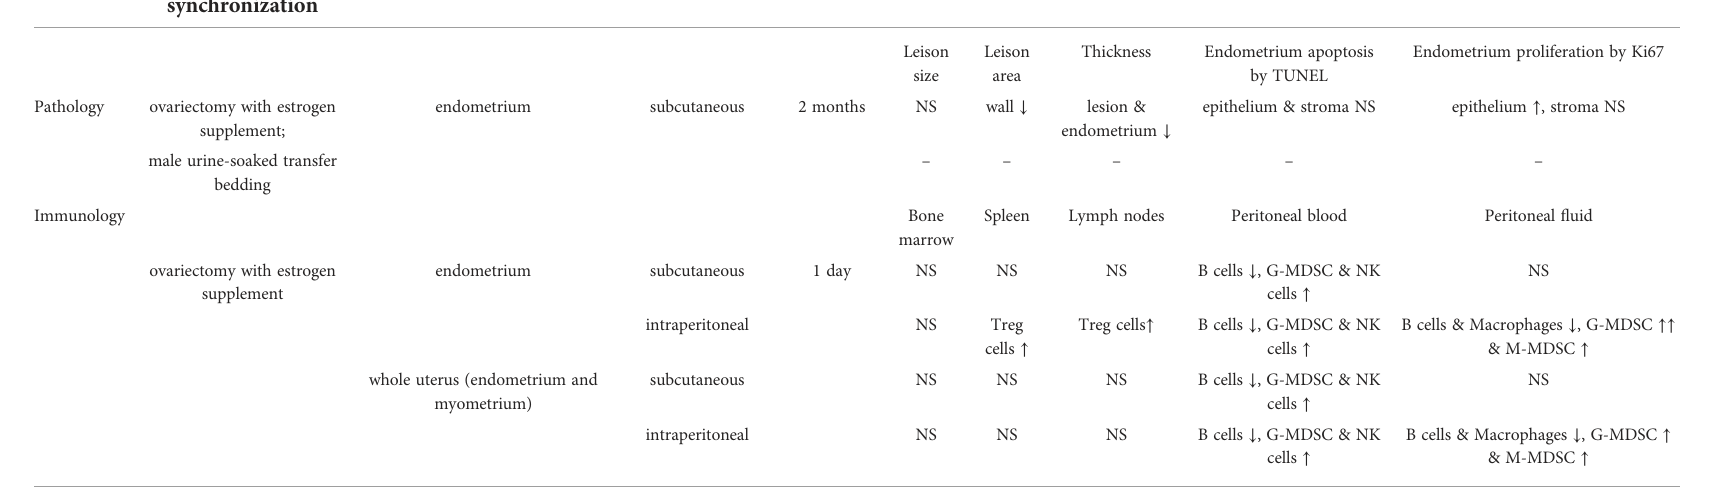
TABLE 1 Summary of experiments and